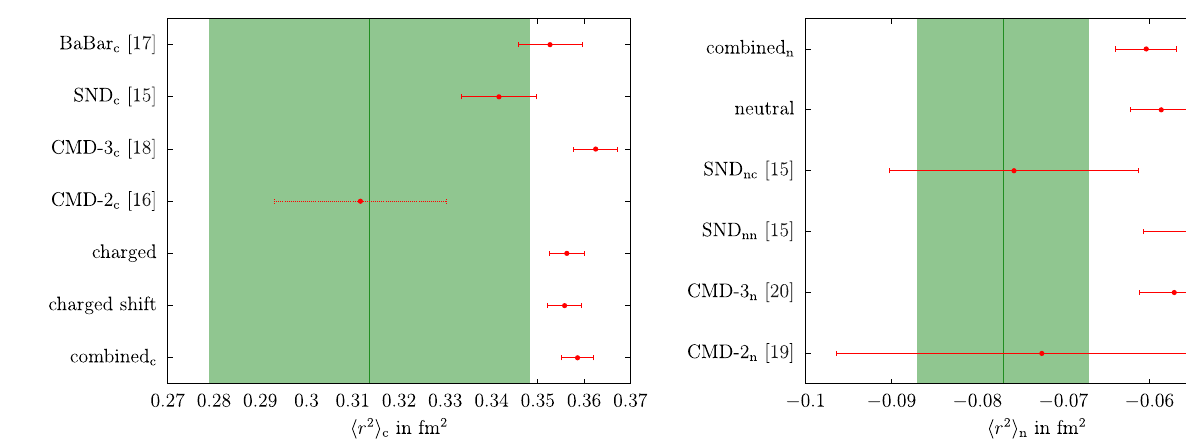
convention as in Fig. 2. The uncertainty is obtained by adding the fit uncertainty and the systematic error from the UFD input in quadrature. The green band denotes the value quoted in Ref. [26]